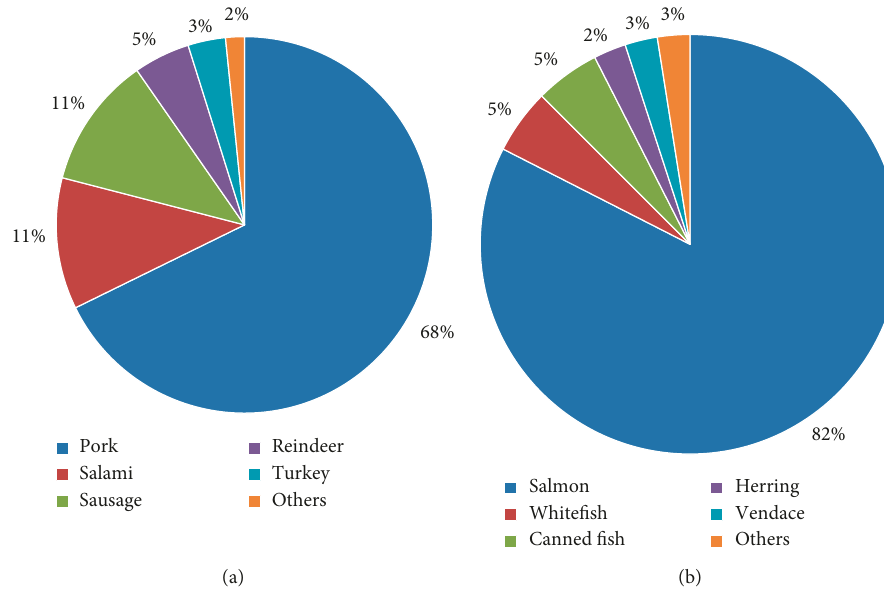
Figure 1: Percentage distribution of sampled (a) smoked meat ( n